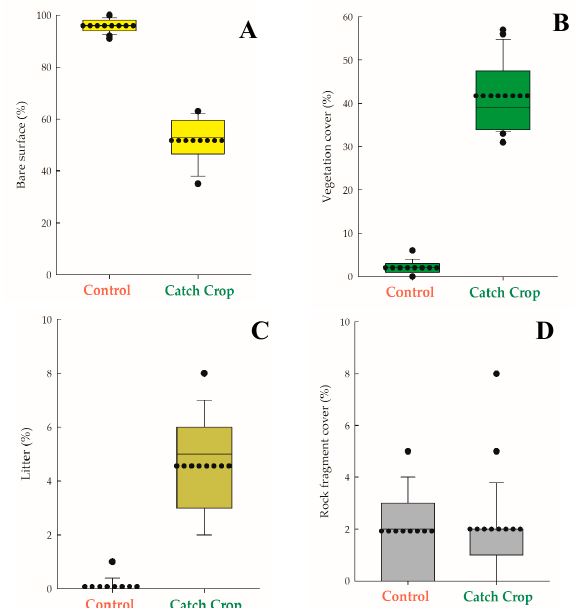
Figure 3. Soil cover characteristics in the control and catch crop ( A ) plots: vegetation ( B ), litter ( C ), and rock fragments cover ( D ). Continuous line: median values; dotted line: mean values; circles: outliers; 5th and 95th percentiles are also represented per box plot.